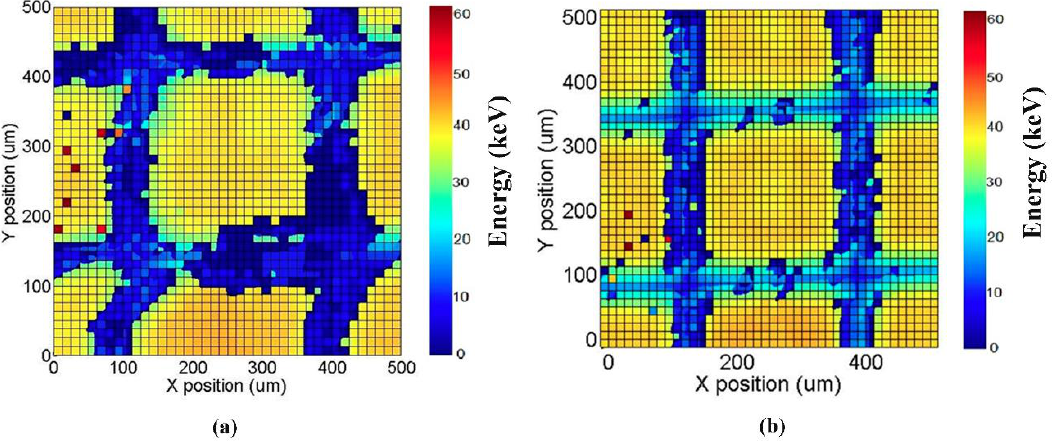
Figure 8. The results of a 2D synchrotron X- ray mapping of the small 250 μm array at 40 keV, for ( a ) ( a ) the LF-CZT and ( b ) HF-CZT detectors. The changes in the photopeak energy are confined near